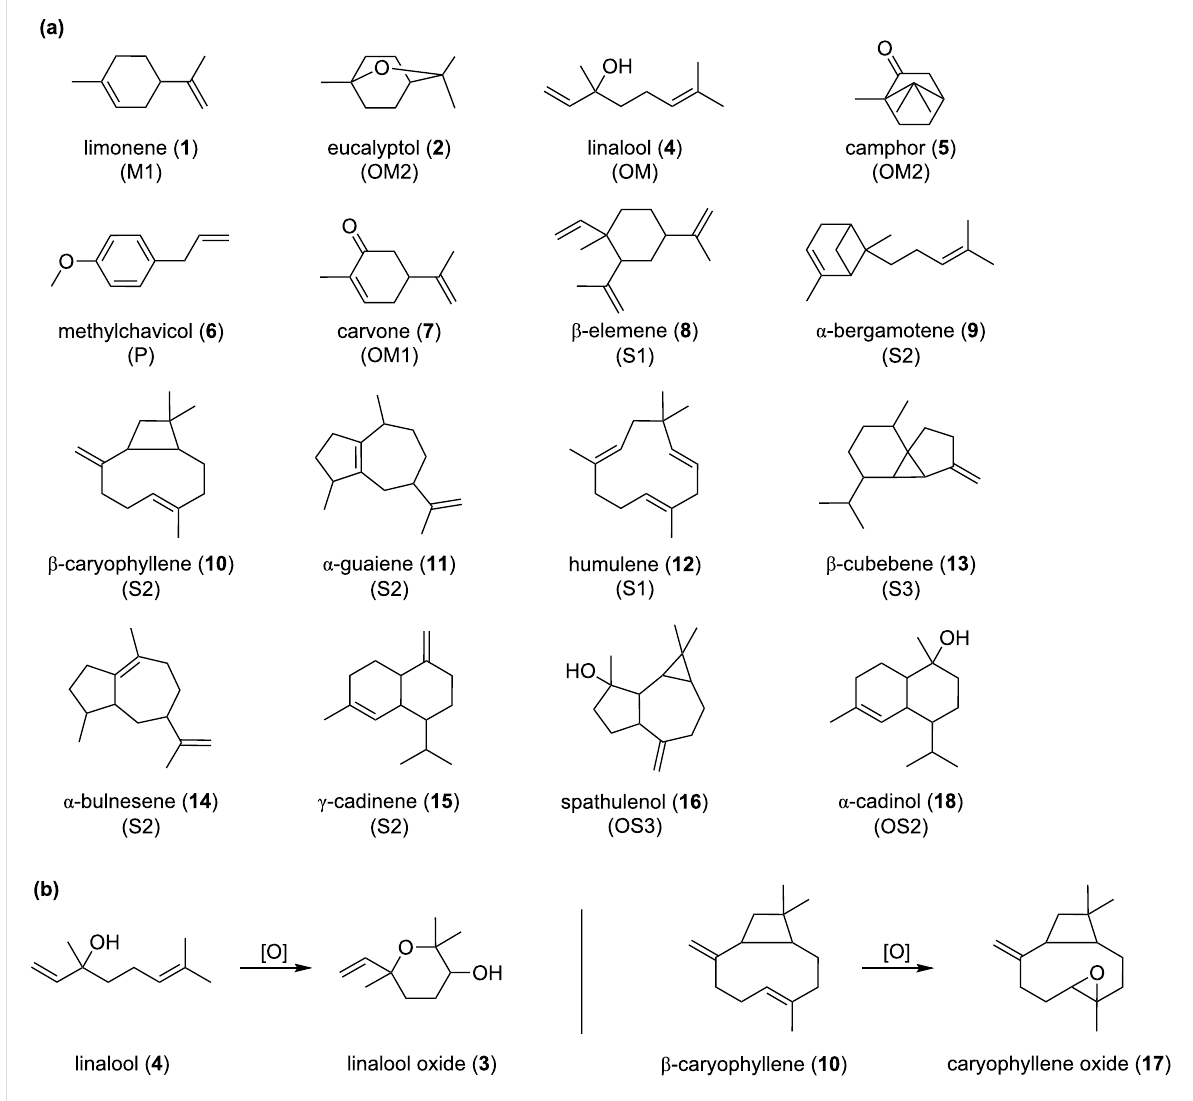
Figure 1: The main compounds identified in raw O. basilicum L. essential oils (a) and the degradation reactions for some labile compounds (b). The number given for each compound can correspondingly be found in Table 1. The compound class is indicated in parenthesis (M – acyclic monoter- penes, OM – oxygenated acyclic monoterpenes, OM1/2 – oxygenated mono/bicyclic monoterpenes, P – phenolic derivatives, S1/2/3 – mono/bi/ tricyclic sesquiterpenes, OS2/3 – oxygenated bi/tricyclic